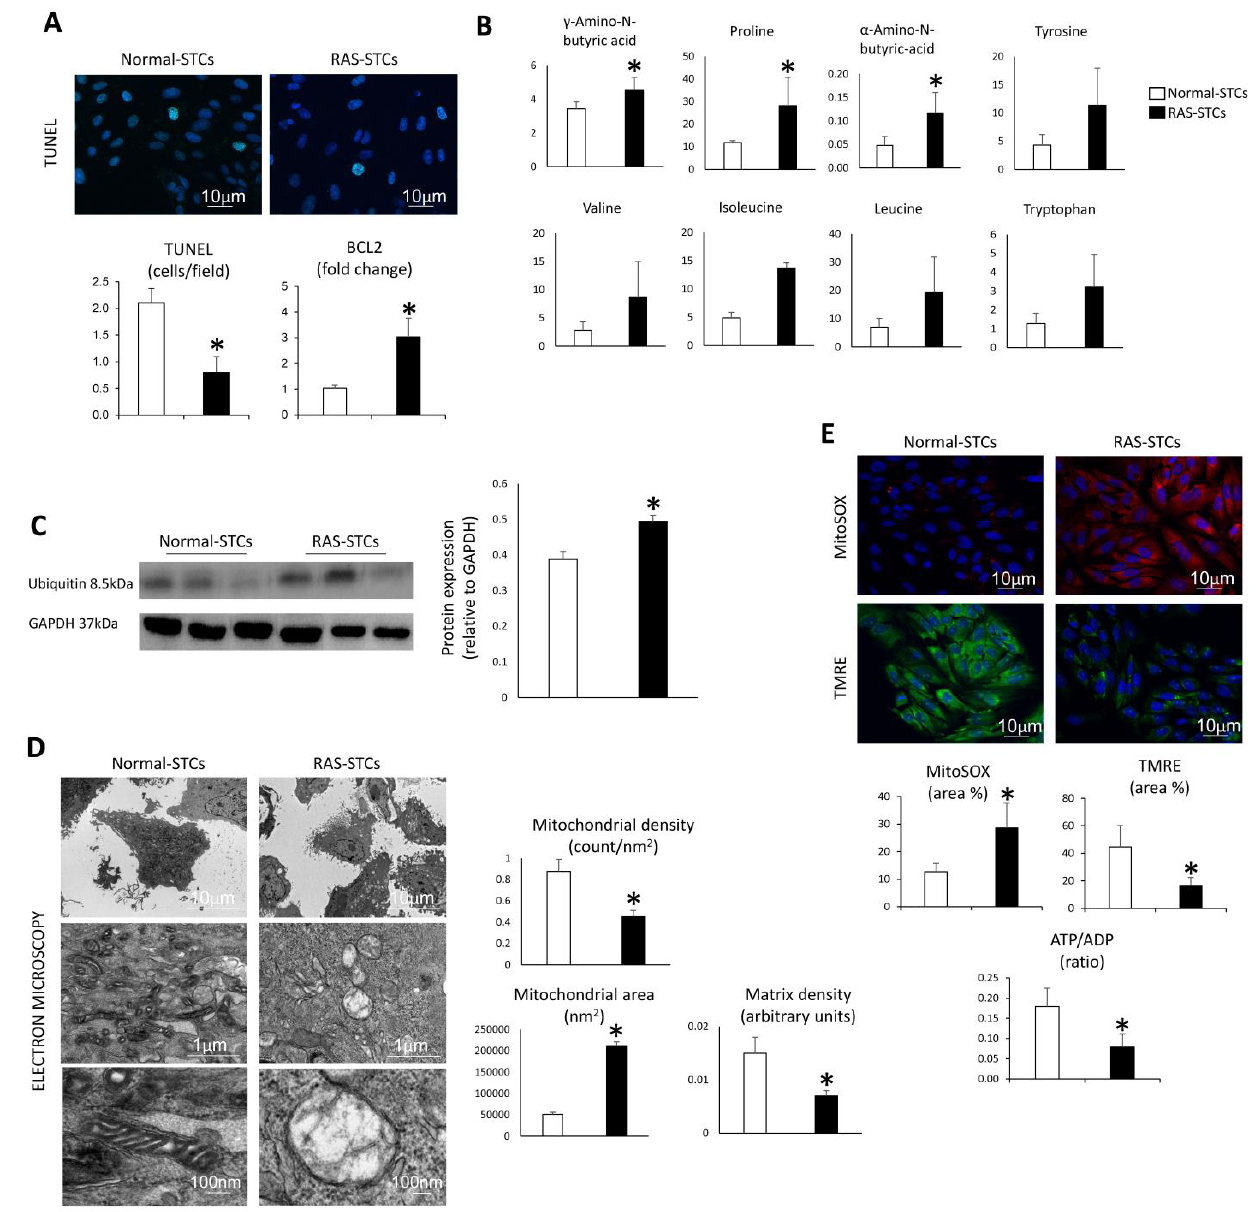
Figure 5. RAS alters apoptosis, proteolysis, and mitochondrial function in swine STCs. ( A ) Representa- tive images of TUNEL staining and its quantification, as well as quantification of BCL-2 expression (qPCR) in Normal- and RAS-STCs. ( B ) Quantification of amino acid metabolites (LC-MS) in Normal- and RAS-STCs. ( C ) Protein expression of ubiquitin (Western blotting) in Normal- and RAS-STCs (Fig- ure S1). ( D ) Representative transmission electron microscopy images and quantification of mitochon- drial density, area, and matrix density in Normal- and RAS-STCs. ( E ) Mito-SOX (red) and tetramethyl- rhodamine ethyl ester (TMRE, green), and mitochondrial ATP generation (ATP/ADP ratio) in Normal- and RAS-STCs. * p < 0.05 vs. Normal-STCs.